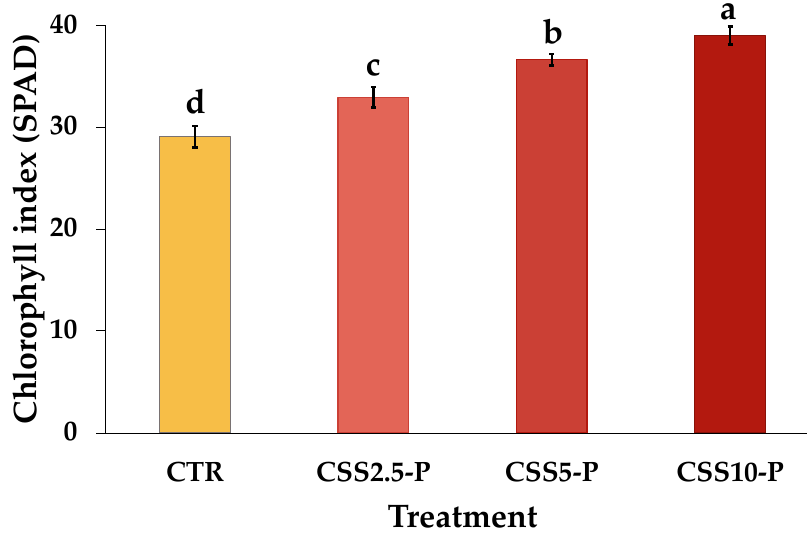
Figure 3. Chlorophyll index (SPAD) of lettuce in soil amended with different doses of CSS: control (CTR), 2.5 t ha − 1 CSS2.5-P, 5 t ha − 1 (CSS5-P), and 10 t ha − 1 (CSS10-P). Different letters indicate significant differences among treatments at p < 0.05.